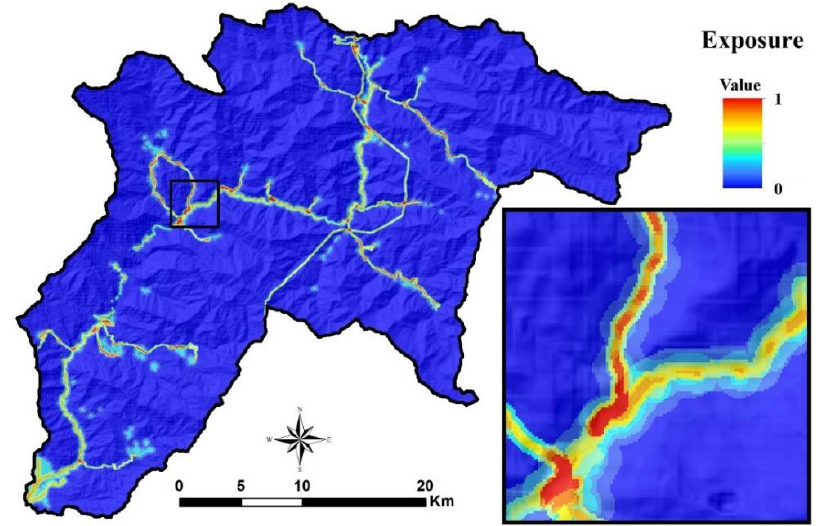
Figure 9. Exposure map of the study area.